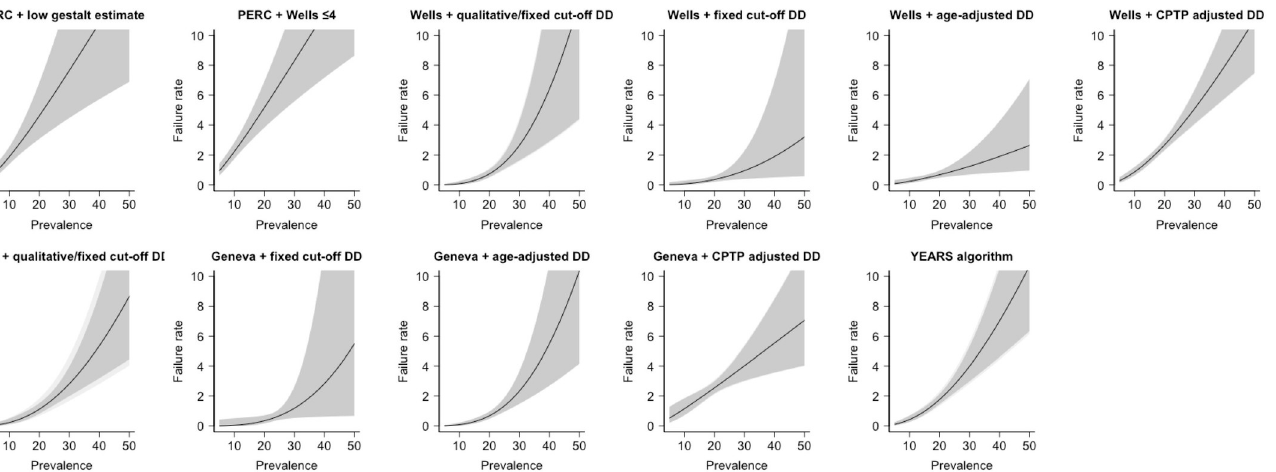
Fig 2. The relationship between the prevalence of PE and failure rate of each diagnostic strategy. Gray shaded area shows 95% CI, and light gray shaded area shows 95% PI. CI, confidence interval; (C)PTP, (clinical) pretest probability; DD, D-dimer; PE, pulmonary embolism; PERC, Pulmonary Embolism Rule-out Criteria; PI, prediction interval; PTP, pretest